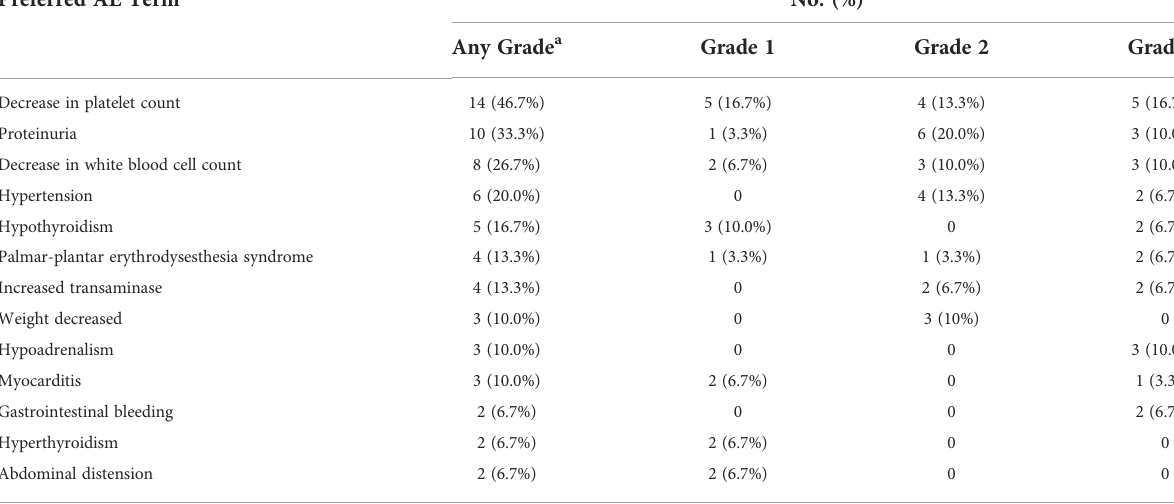
TABLE 4 Treatment-related AEs in patients receiving lenvatinib plus anti-PD-1 antibody (n = 30).